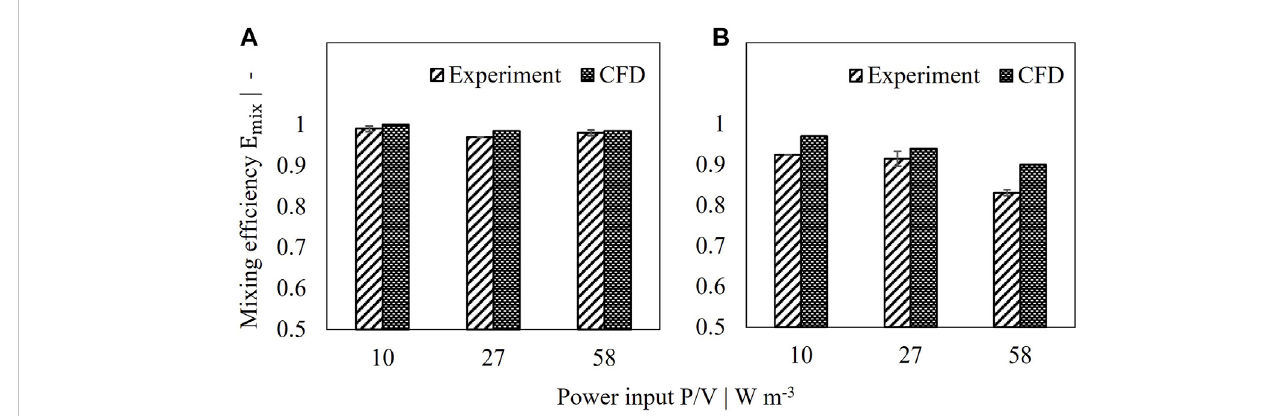
FIGURE 3 Comparison of simulated and measured mixing ef fi ciency of 2 L perfusion tank. (A) Setup I, (B) Setup II.